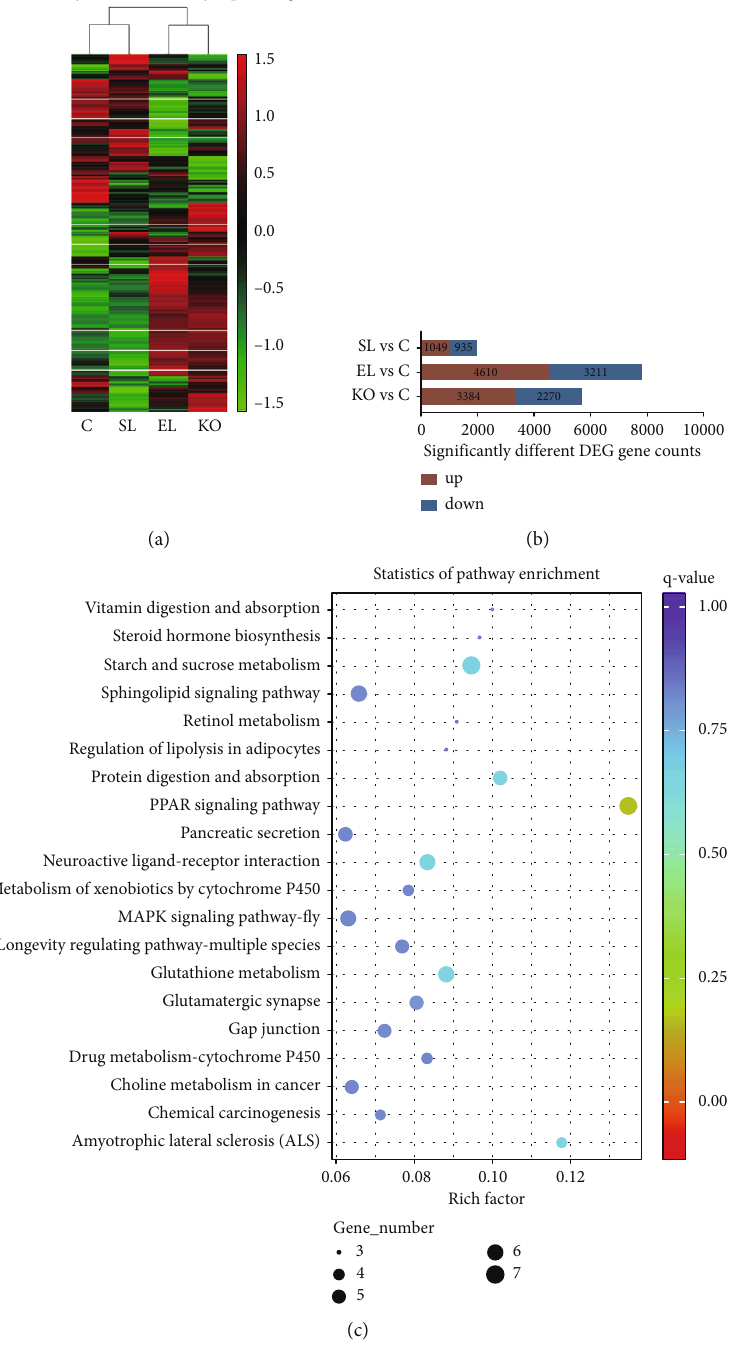
Figure 9: Clustering heatmap analysis of di ff erentially expressed genes in the ovaries of C. quadricarinatus among the four experimental groups (a). Number of signi fi cantly changed gene counts in the ovaries of C. quadricarinatus between the three experimental groups and the control (b). Scatterplot for pathways in KEGG enrichment of di ff erentially expressed genes in the ovary of C. quadricarinatus between the KO and EL groups